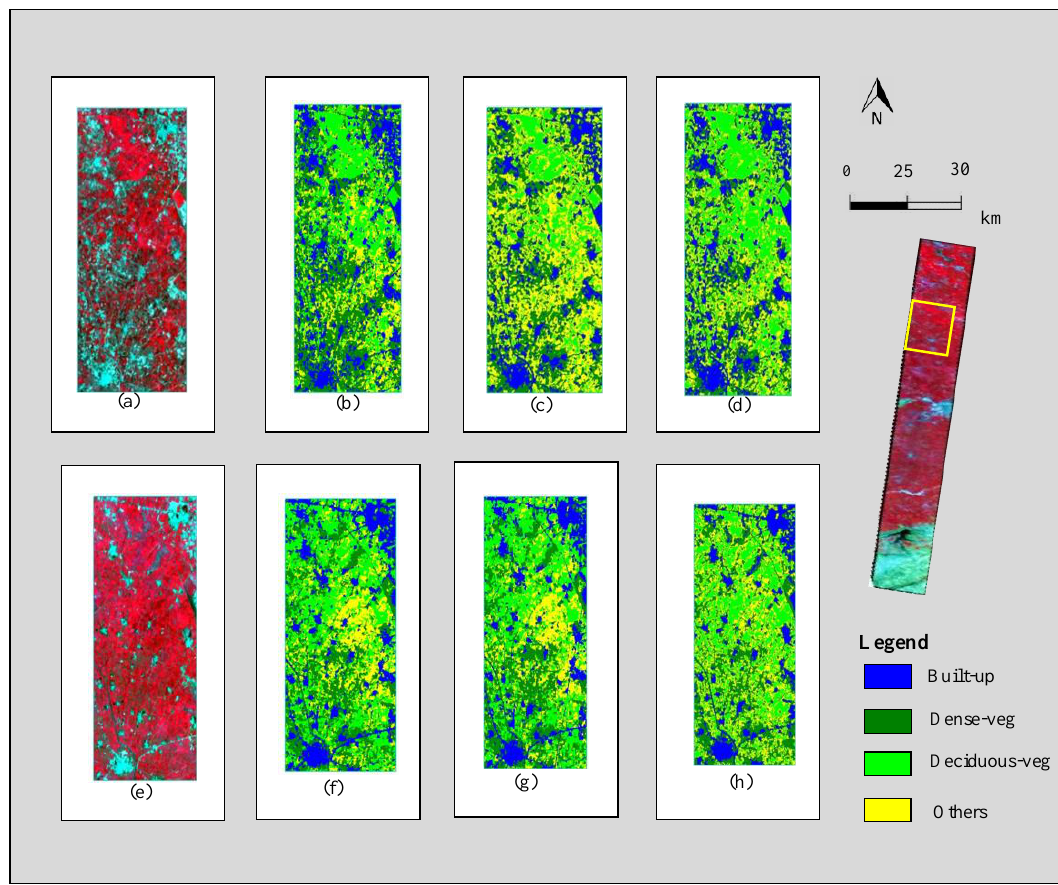
Figure 4. Classified map of (a) Hyperion imagery (24-Feb-2005) computed from (b) ANN (c) KNN (d) SAM; (e) Hyperion imagery (09-Feb-2014) computed from (f) ANN (g) KNN (h) SAM